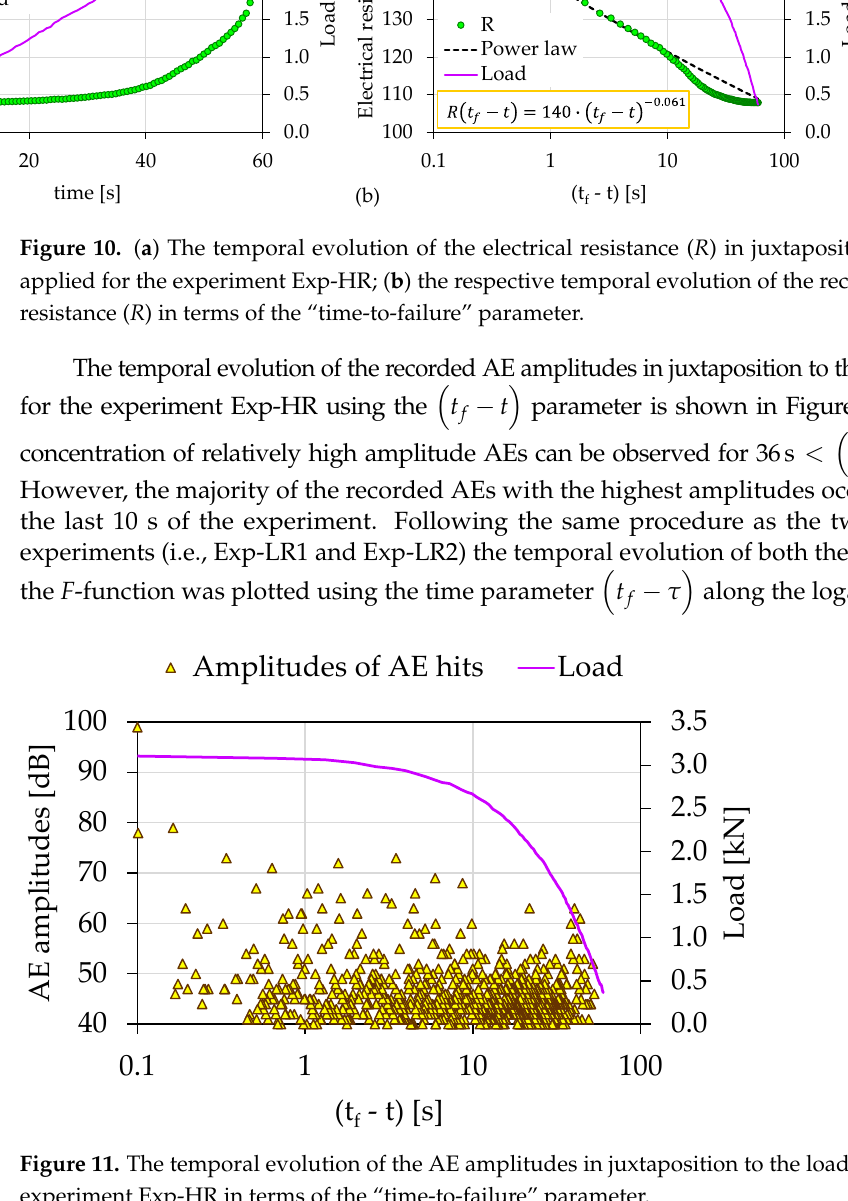
) τ− t parameter. Here, f